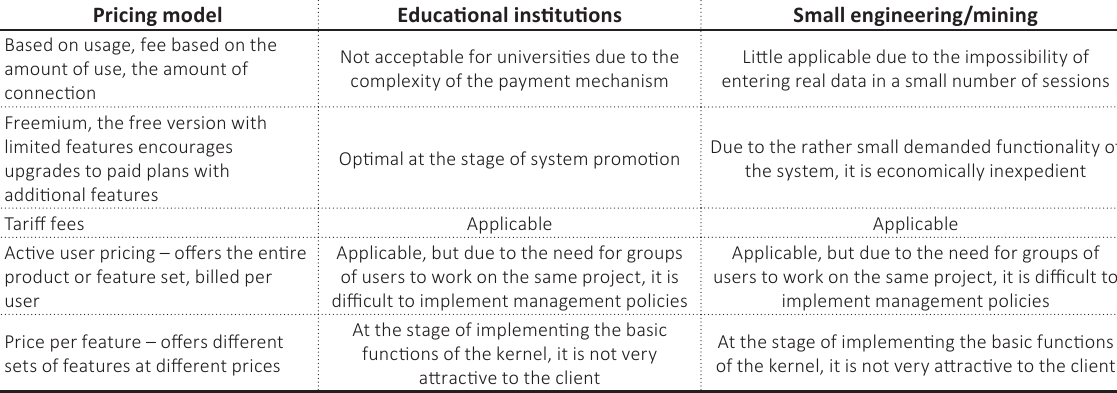
Table 5. Choosing a SaaS product pricing